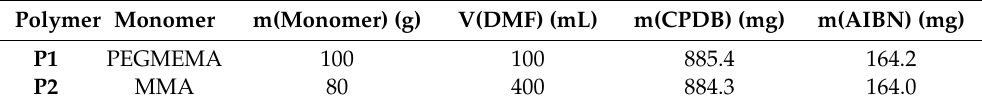
Table 1. Summary of utilized amounts and volumes for the RAFT polymerizations of